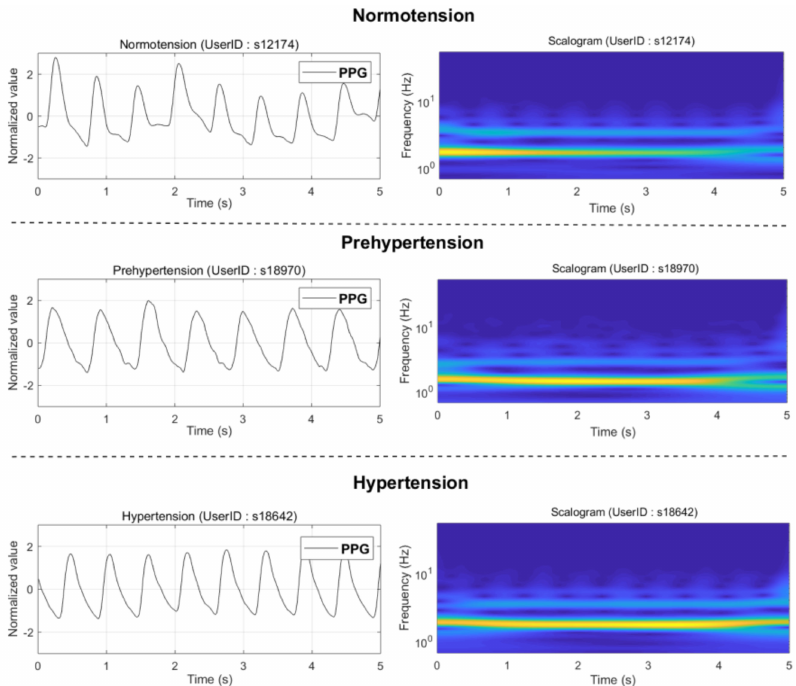
Figure 2. The scalogram cases of the three different blood pressure categories. Note: PPG stands for photoplethysmogram